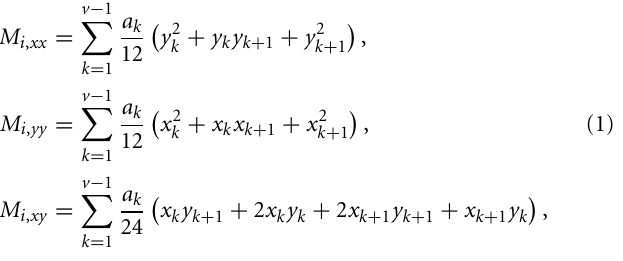
growth of an individual, anisotropic target ellipse represented by a ( 0 ) matrix M . The actual shape of a given cell yields a form matrix i M i = ( M i,xx , M i,xy , M i,xy , M i,yy ) defined as the second moment of area of its v vertices with position x , y